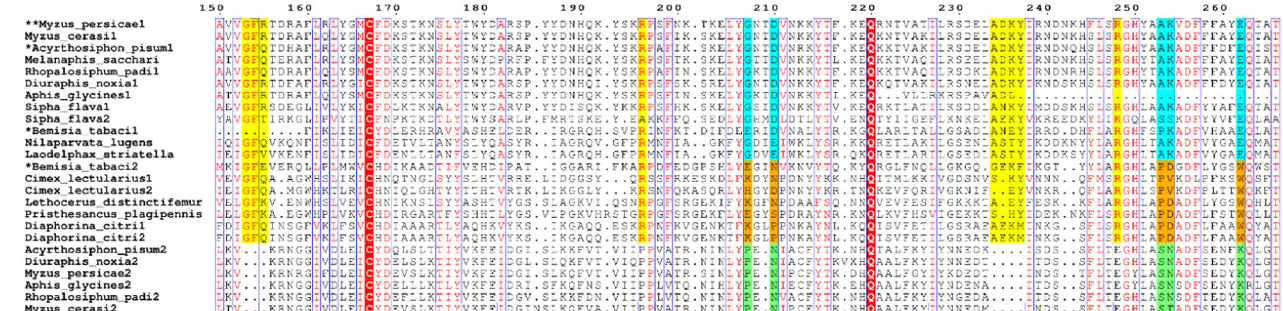
Figure 7. Alignment of three independent hemipteran clades. Sequence features distinctive to clade 1 endonucleases are shown in cyan, those for clade 3 are shown in orange and those for clade 2 are shown in light green. Deletions in clade 2 are shown with yellow colour highlights. Red colour highlights show conserved residues. Red colored residues have similar chemical